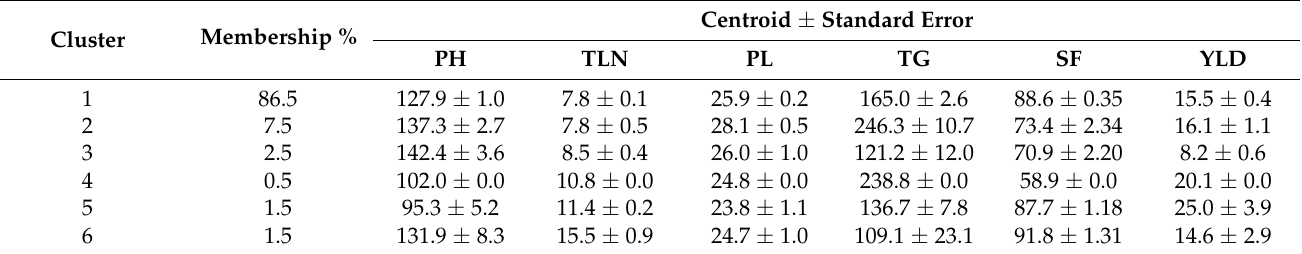
Table 3. Centroids of agro-morphological data of tropical japonica lines based on phenotypic diver- gence with standard error.